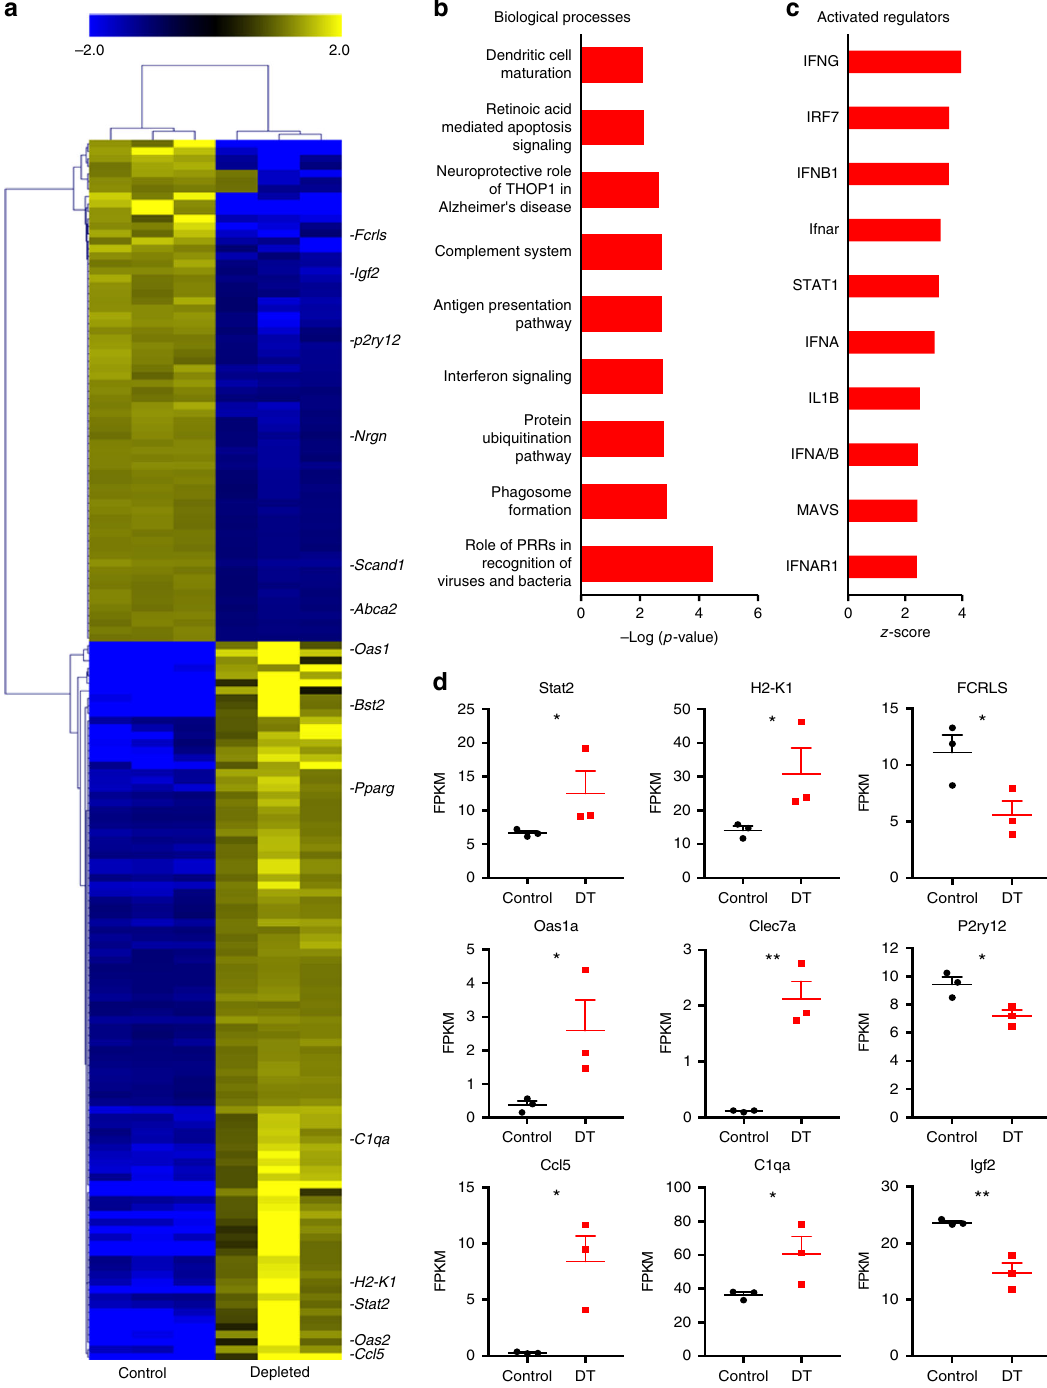
Fig. 3 Type 1 interferon in fl ammatory signature associated with acute neurodegeneration. a Heatmap depicts hierarchical clustering of upregulated (yellow) and downregulated (blue) genes in cortical tissue from d10 microglia-depleted mice identi fi ed by DeSEQ2 analysis of TMM normalized RNA-Seq values. b , c Bar graphs depict Ingenuity pathway analysis of the 10 most signi fi cant biological processes and predicted upstream regulators of the DE genes in the dataset. d Dot plots demonstrate the FPKM (fragments per kilobase million) values in cortical tissue from control (black) and depletion (red). Cortical tissue from ataxic mice demonstrated upregulation of type 1 interferon pathway genes and genes associated with microglia activation, and lower expression of genes associated with a neuronal and microglia homeostasis. Error bars depict SEM and n = 3 mice per group. Analyzed with Student ’ s unpaired t- test at 95% con fi dence interval and * p < 0.05, ** p <